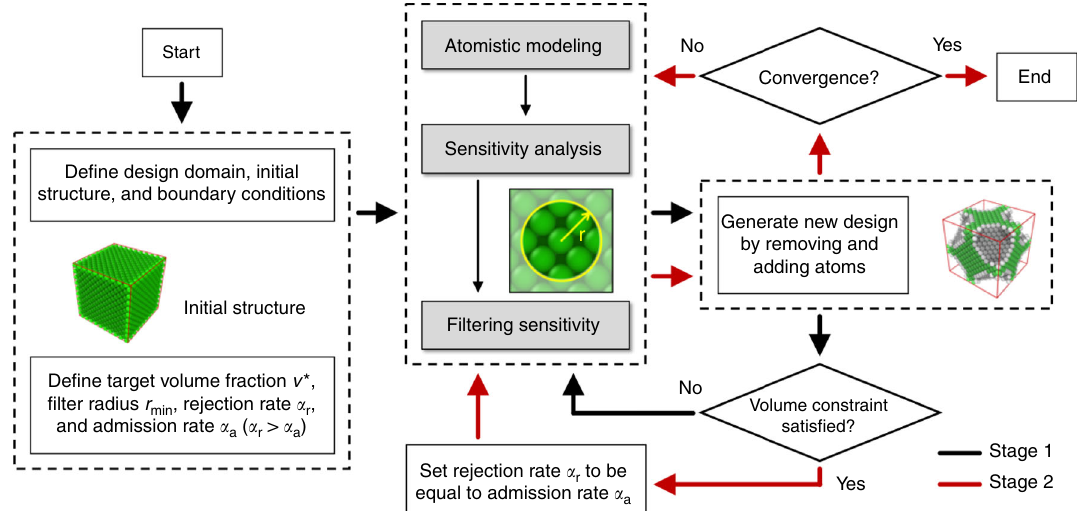
Fig. 1 Flowchart of Nano-TO. The fl owchart shows the approach of Nano-TO to design materials at the nanoscale with atom-by-atom control. The black and red arrows represent the two optimization stages (stage 1 and 2),